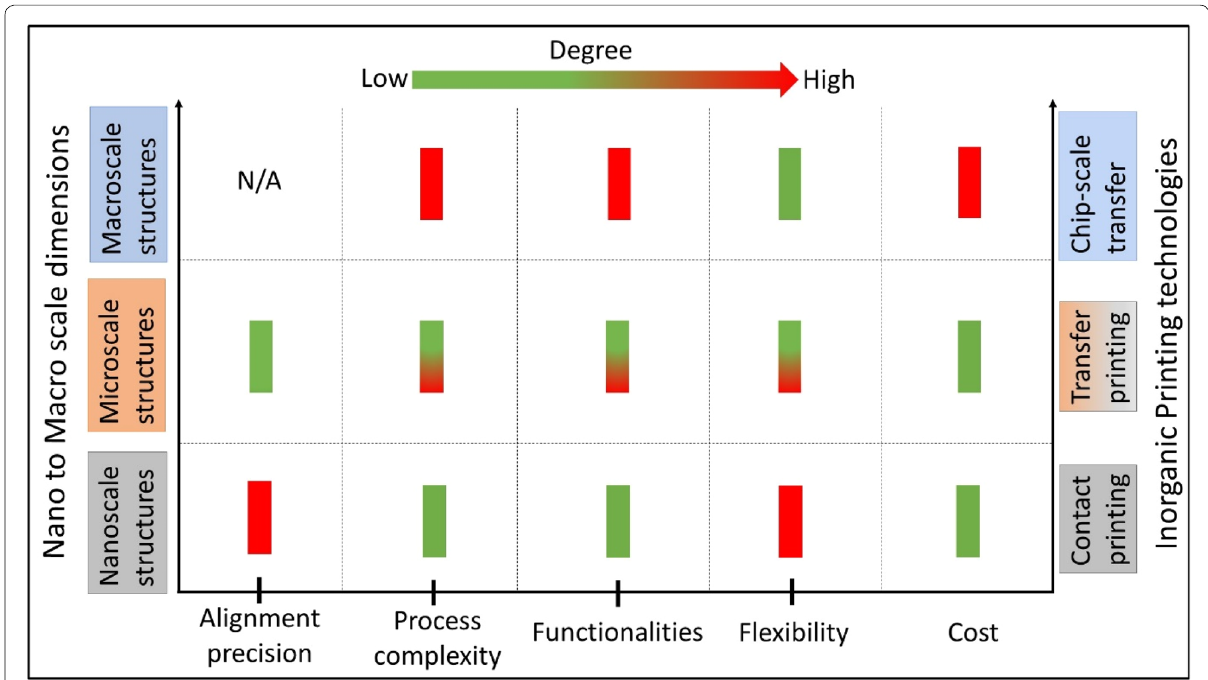
Fig. 8 Summary of key features of the printing technologies for the fabrication of flexible large area electronics using diverse inorganic functional inks ranging from nanoscale to macro scale structures. Colour coding is done to show the use of respective printing technology for the transfer of selective scale of inks. For example, contact printing (grey) is generally employed for the transfer of nanoscale structures (grey). N/A, not